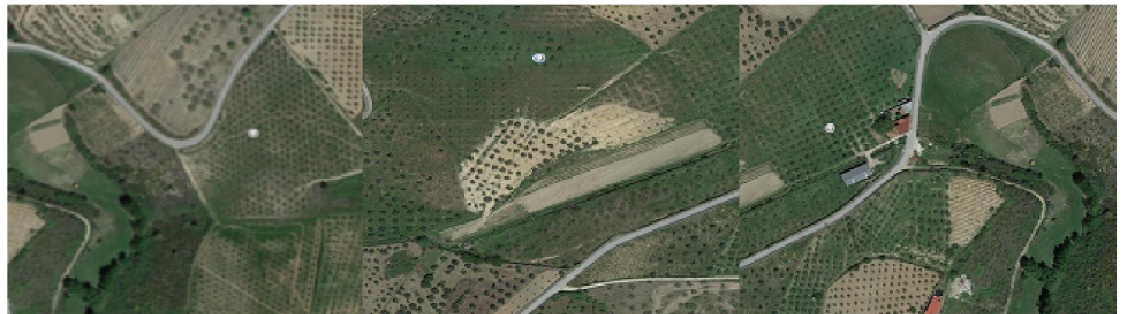
Figure 2. Photos of the harvesting local (aerial view obtained from Google maps according to the respective coordinates). Cultivar (from left to right): Madural, Verdeal, and